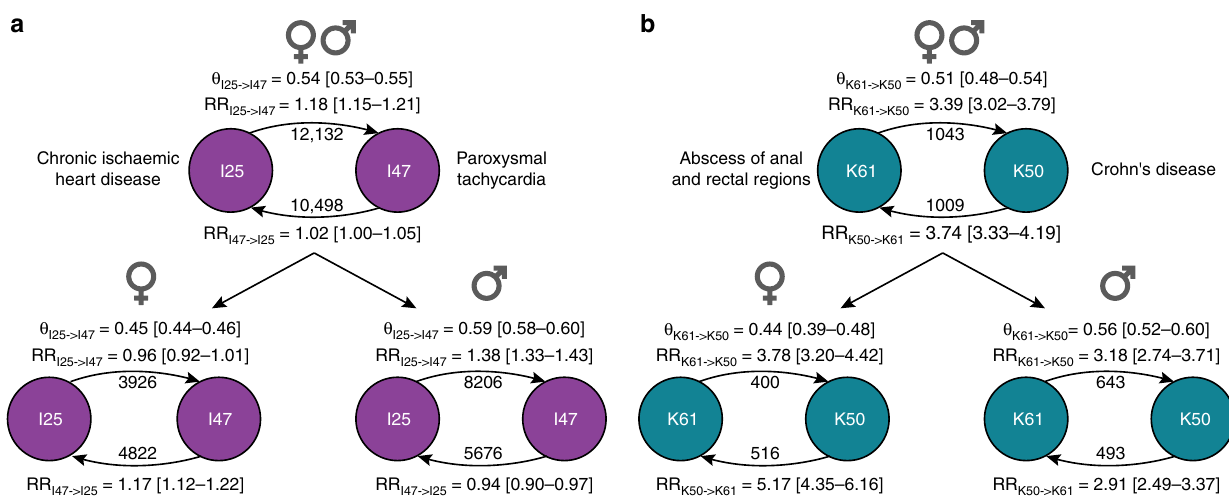
Fig. 4 Opposite temporal relationships in men and women. a At the population level, paroxysmal tachycardia (I47) is observed to be a complication of ischemic heart disease (I25). The sex-strati fi ed analysis showed that this pattern only existed in men, and that the reversed pattern was signi fi cant in women. b At the population level, there was no preferred direction of diagnoses between Crohn ’ s disease (K61) and abscesses of anal and rectal regions (K50). However, the sex-strati fi ed analysis found that the directionality was reversed between men and